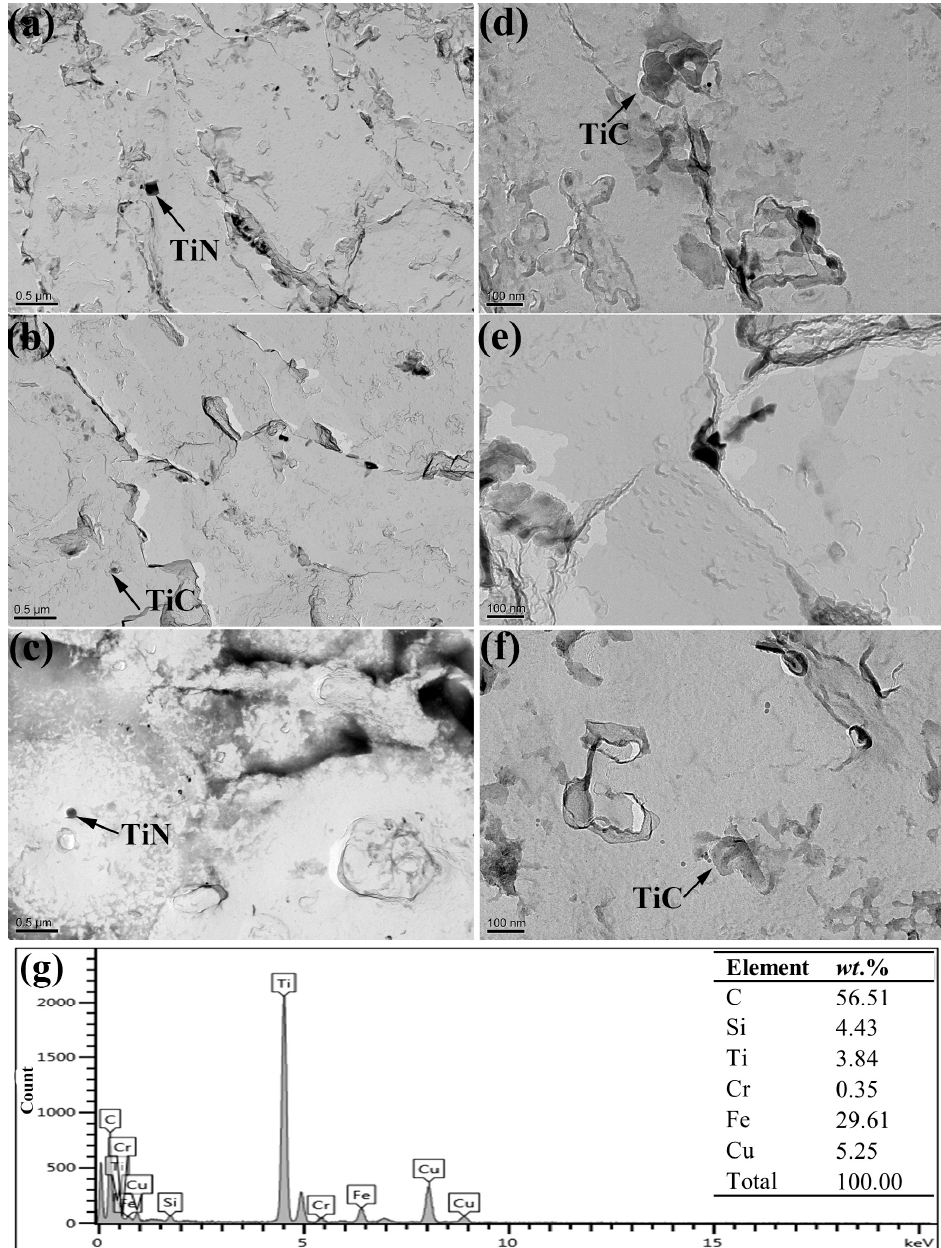
Figure 3. TEM micrographs showing the precipitations of specimen A ( a , d ), specimen B ( b , e ), specimen C ( c , f ), and the corresponding EDS results ( g ).